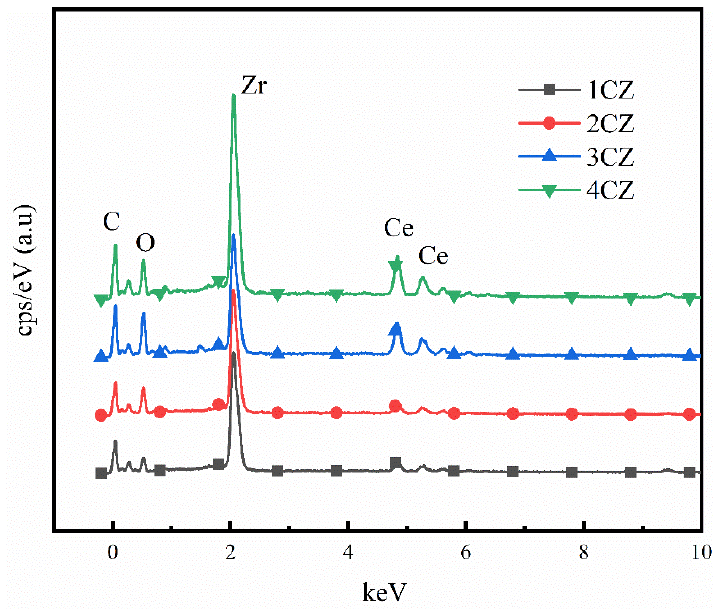
Figure 2. SEM-EDS spectra of the CZ nanoparticles obtained under various operating conditions. Table 2. Composition analyses of the obtained CZ samples.